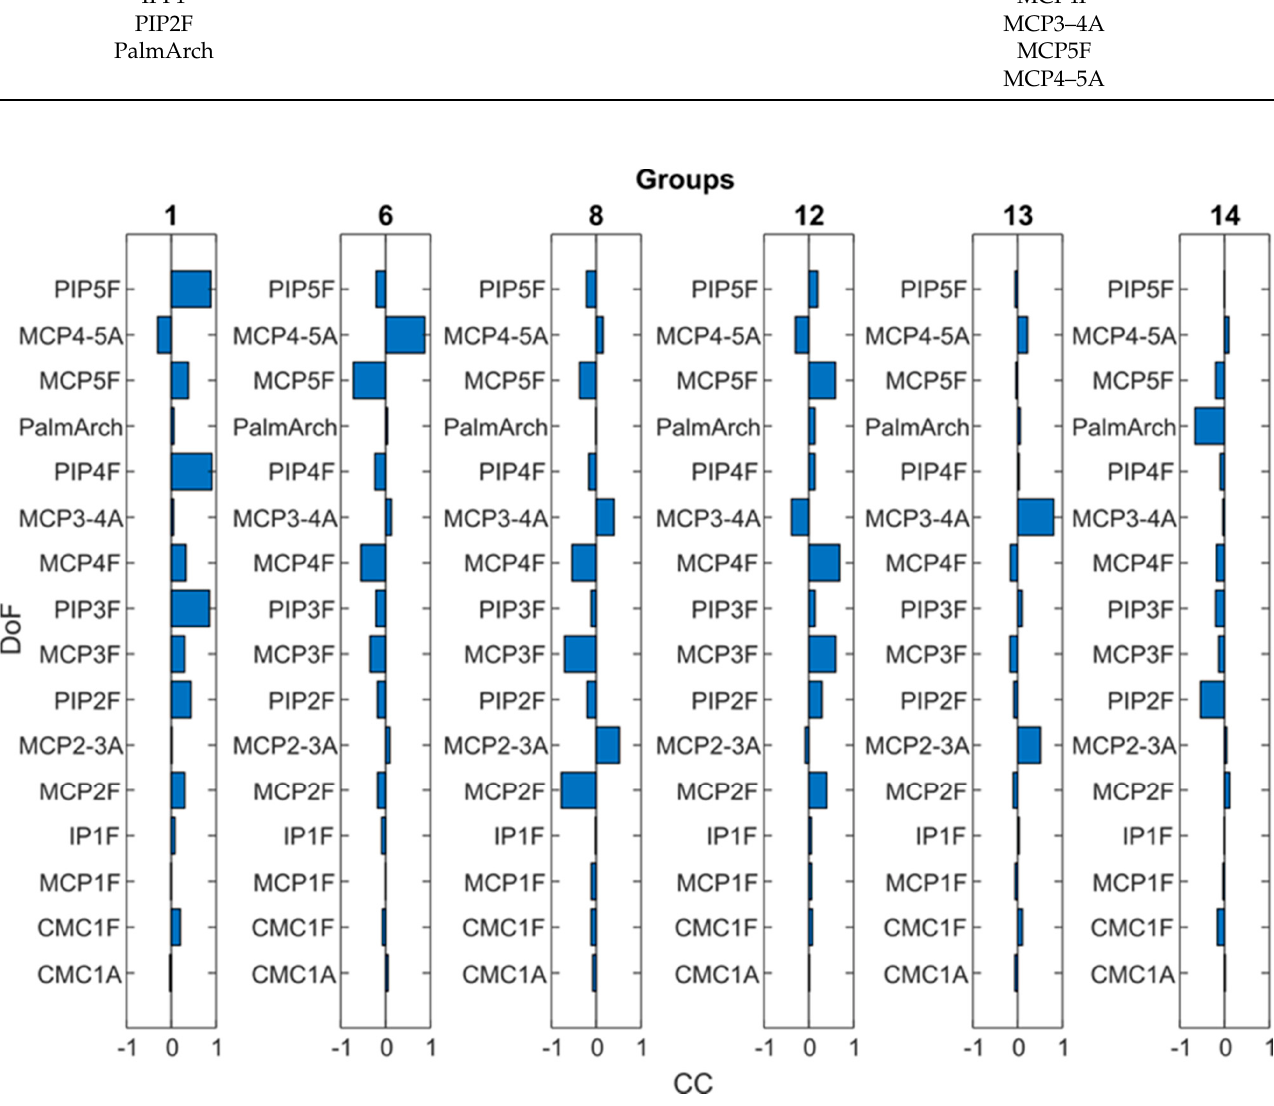
Figure 5. Weight of each DoF movement of the 6 grouped PCs that represent coordination between DoF. 1 to 5 refers to thumb to little fingers. F stands for flexion/extension and A for abduction/adduction movements.